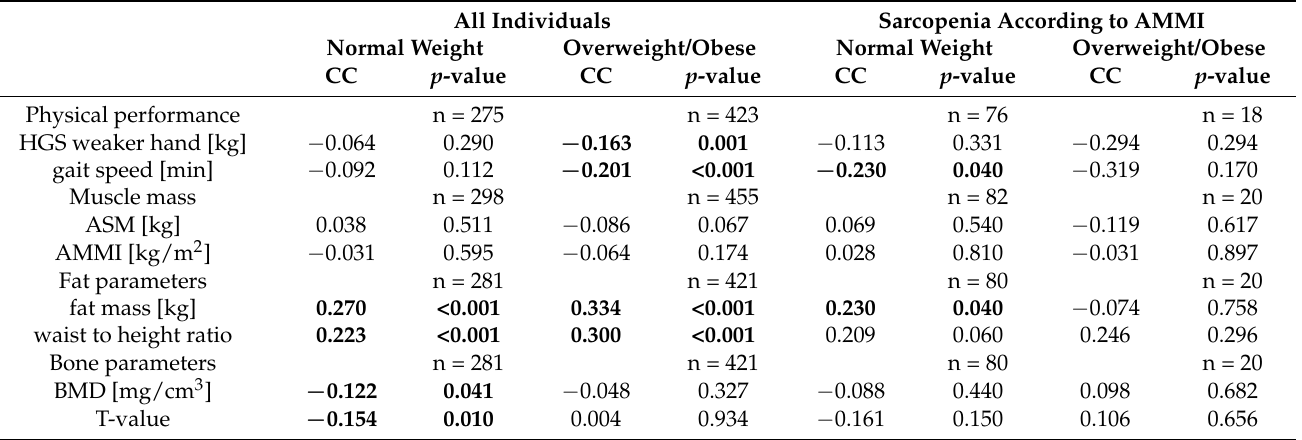
Table 3. Correlations of dp-ucMGP levels with sarcopenia-related muscle parameters, fat and bone parameters according to BMI subgroup.